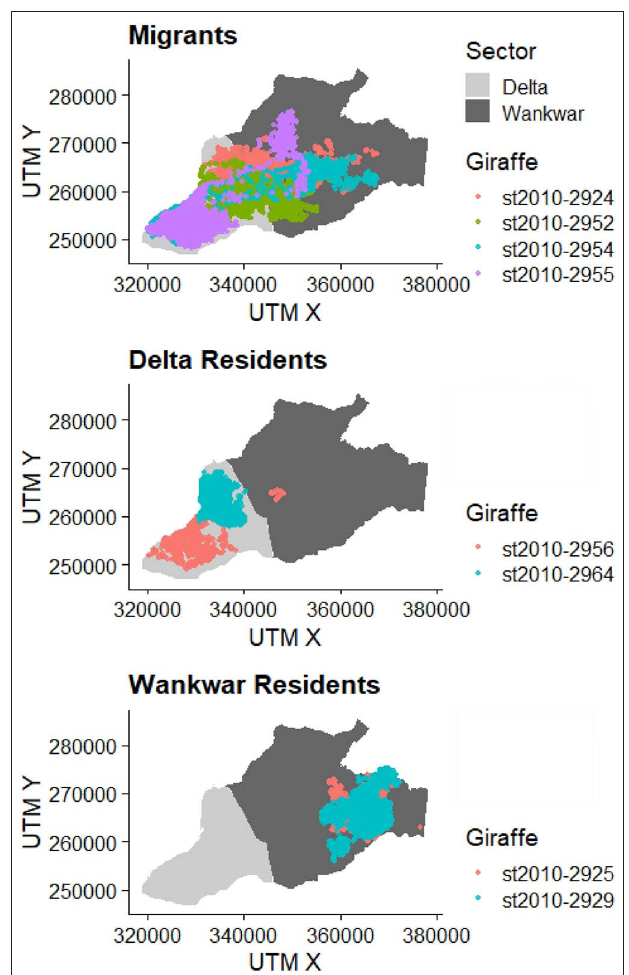
FIGURE 4 | Examples of the movement trajectories of three individual giraffe concurrently exhibiting different seasonal space-use patterns across geographical and ecological